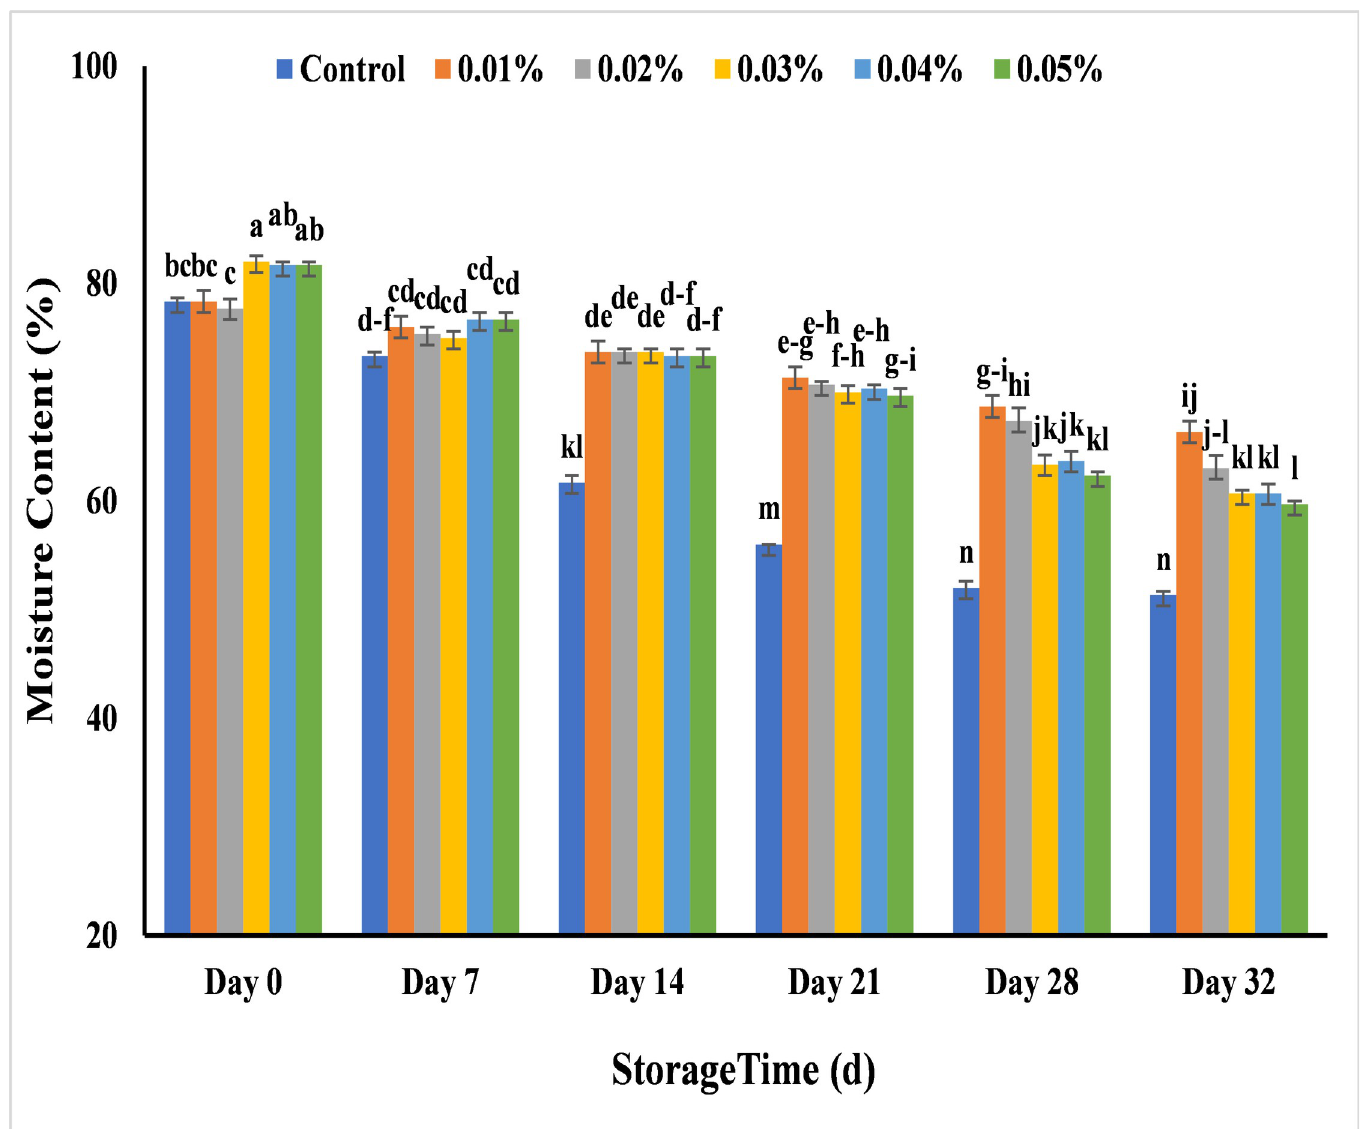
Fig 15. Effect of AgNPs concentrations (T0 = control, T1 = 0.01%, T2 = 0.02%, T3 = 0.03%, T4 = 0.04%, T5 = 0.05%) on moisture content (%) of Cavendish banana (BASRAI) during 32 days of storage.